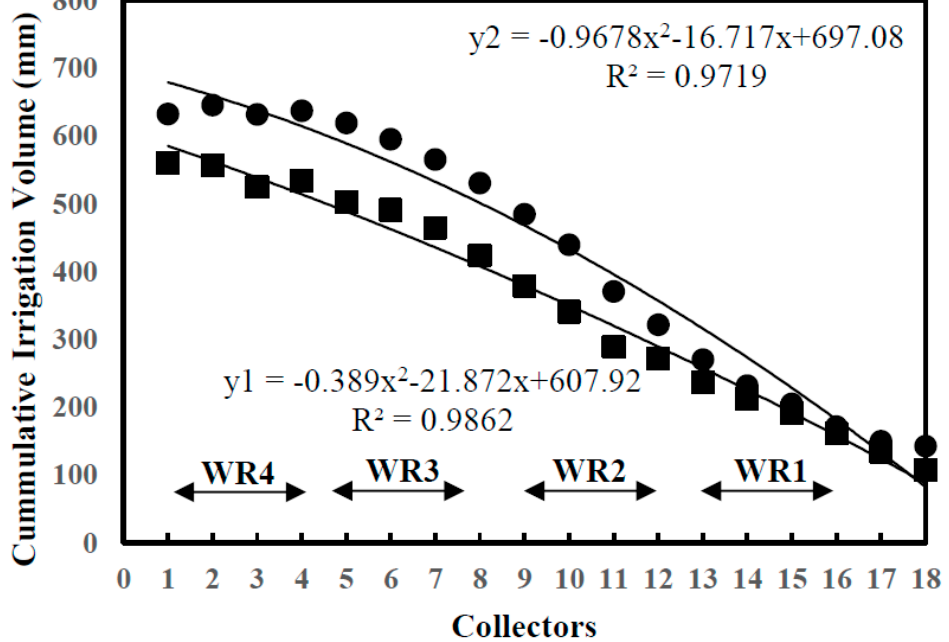
Figure 2. Cumulative irrigation volume applied in soybean crop during the dry season in 2016 (y1) and 2017 (y2).